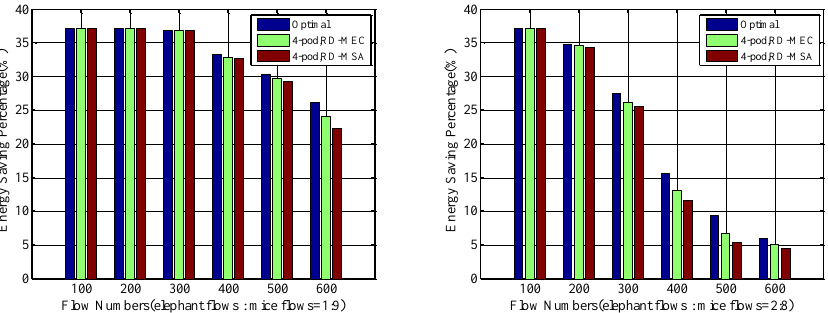
Figure 2. 4-pod Fat-Tree energy savings percentage.